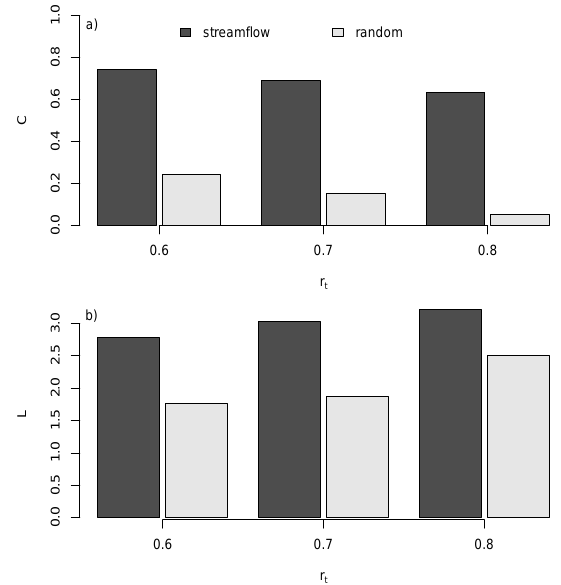
Figure 6. Network clustering coefficient, C , and average shortest path length, L , for the streamflow network and the equivalent ran- dom networks for three values of the correlation coefficient thresh- old, r t